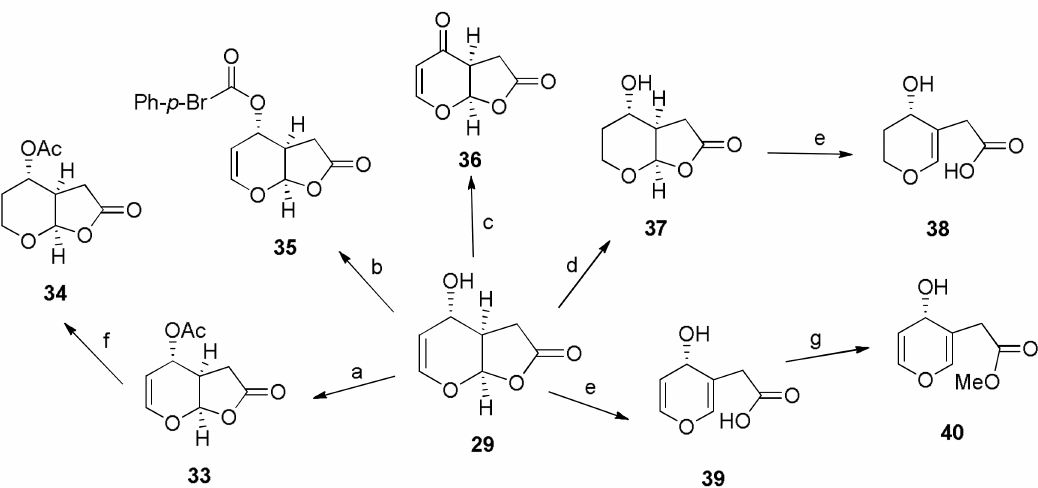
Scheme 6. The structures of oxysporone ( 29 ) and its derivatives ( 33 – 40